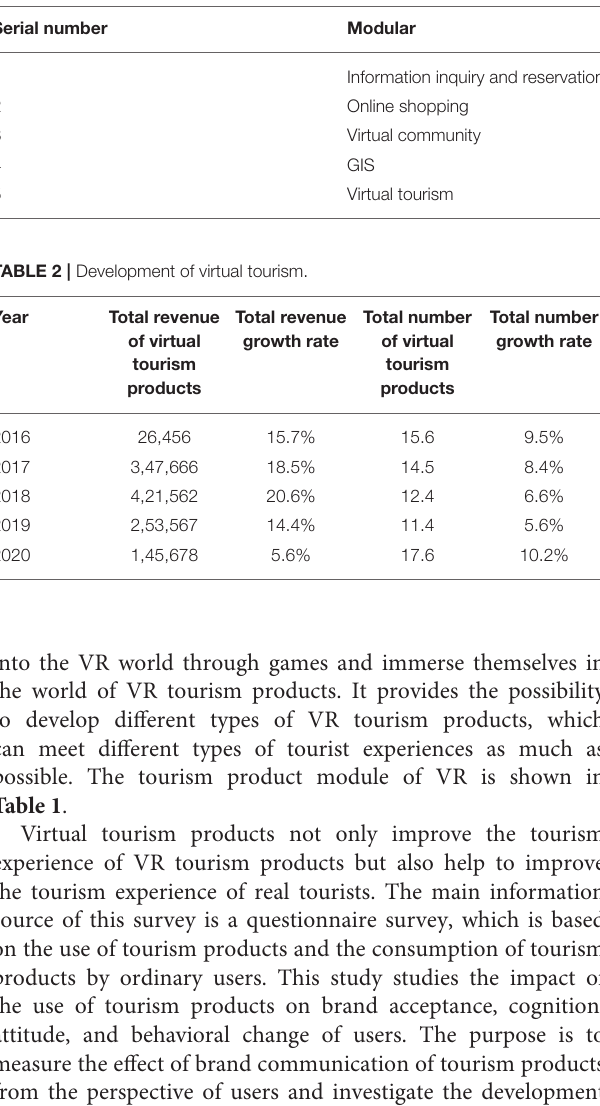
TABLE 1 | Tourism product function module of virtual reality (VR).